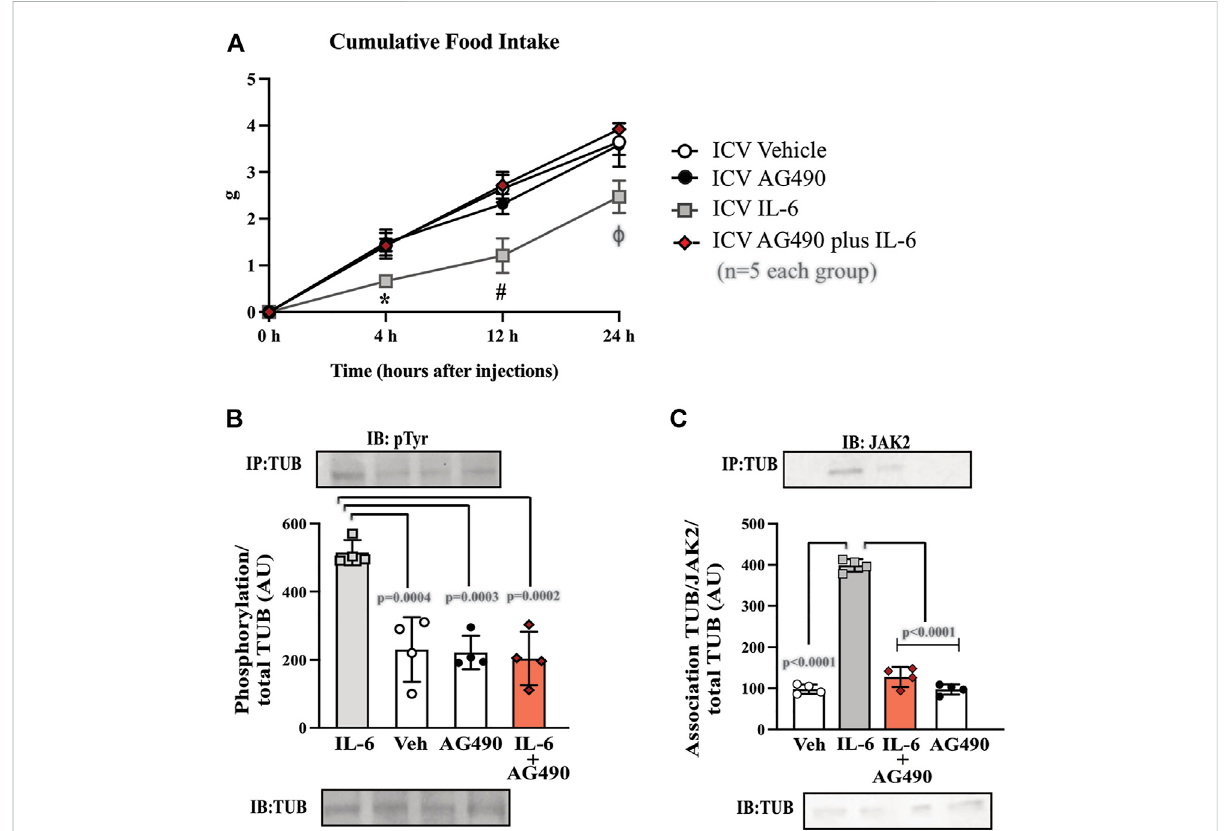
FIGURE 3 HypothalamicIL-6 action throughJAK2 to activate TUB. (A) Evaluation ofcumulativefood intake (g) at4 h, 12 h,and 24 h( n = 5ineach group); Western blot showing (B) TUB tyrosine phosphorylation and (C) TUB associated with JAK2 from hypothalamic lysates from wt/wt mice (6 – 8 weeks old) obtained in the colony of B6- tub/tub mice underresting conditions (Sed). The mice weretreated with vehicle or AG490 (JAK2inhibitor), IL-6, or IL-6 with AG490 by intracerebroventricular (ICV) injections. We used male mice. All values are expressed as means ± standard deviation (SD). Western blot assays ( n = 4 in each group). Two-way ANOVA was used to analyze A, while one-way ANOVA with Tukey ’ s multiple comparisons tests wasusedtoanalyzeBandC.*ICVIL-6vs.Veh,AG490,andIL-6plusAG490( p < 0.0078); # ICVIL-6vs.Veh,AG490andIL-6plusAG490( p <